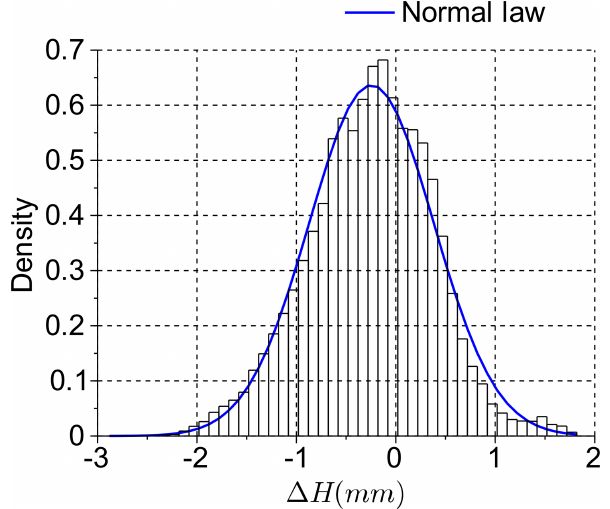
Figure 3. The elevation difference distribution comparing the DEM from Agisoft and the DEM generated using a laser scan. The mean value is − 0.25mm (the mean absolute value is 0.53mm) and the standard deviation is 0.62mm (the mean absolute standard devia- tion is